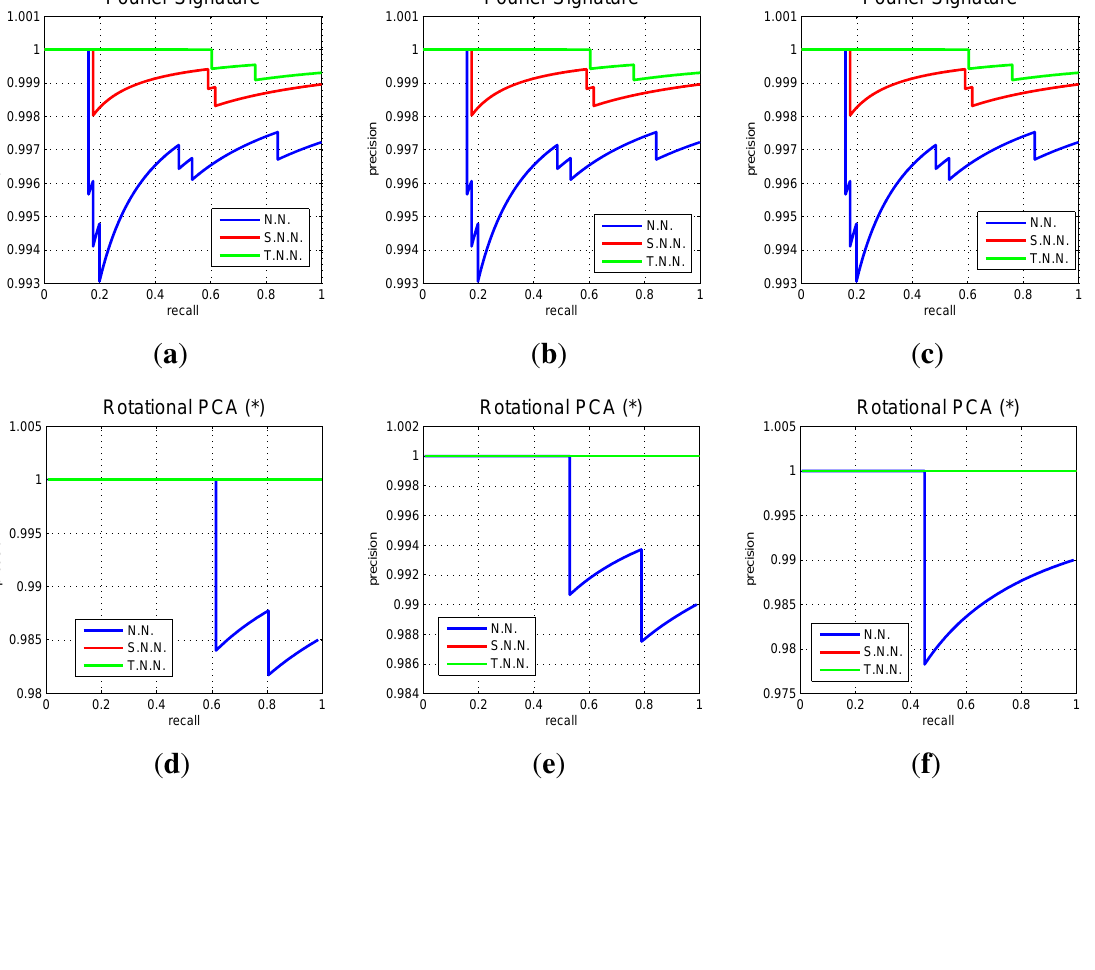
Figure 10. COLD database. Recall and precision curves for FS and k components, PCA with rotations and N = ( d ) 8, ( e ) 16, ( f ) 32 rotations, HOG and k 4, ( h ) 16, ( i ) 64 cells and gist and k